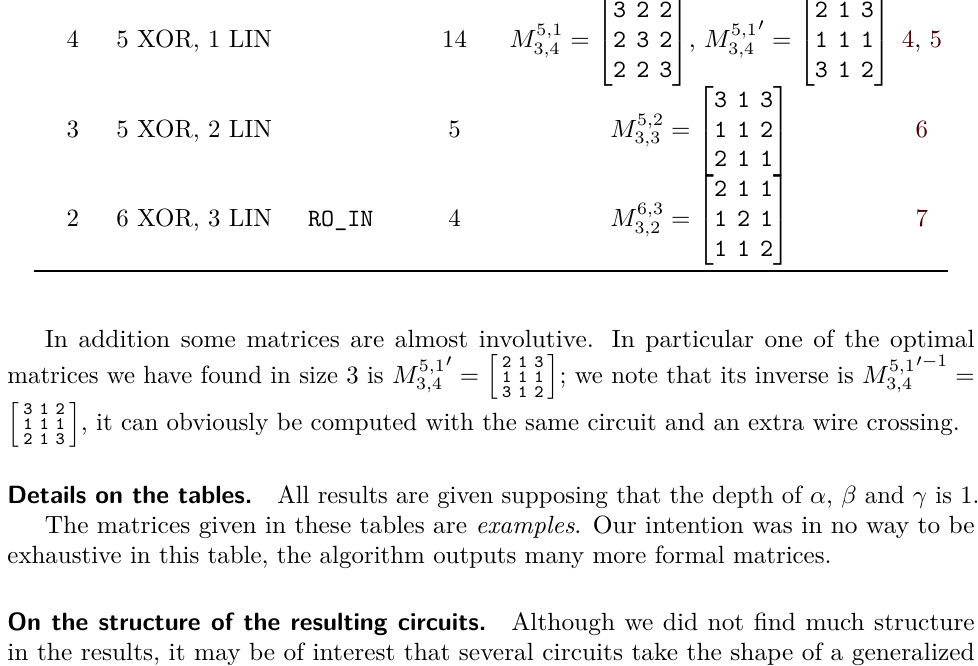
Figure 1: 4 × 4 MDS with depth 5: M 8 , 3 Table 3: Optimal 3 × 3 MDS matrices (all results are obtained in less than 1 second, memory is given in MB).